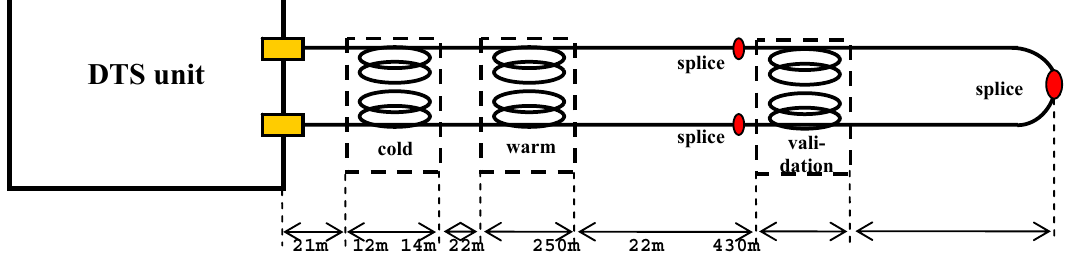
Figure 1. Schematic set-up for calibration test. Lengths are not to scale. The forward and reverse fibers were enclosed in a PBT tube (duplex cable). Between warm bath and first splice and between validation bath and end splice, the cable was lying at the bottom of a water